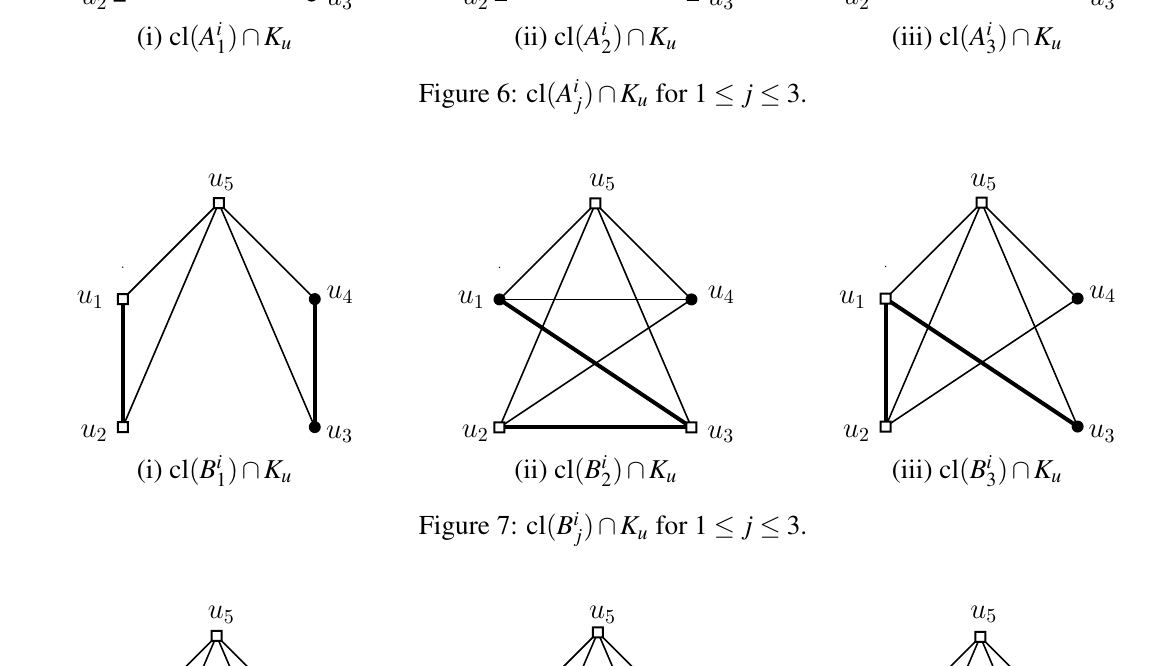
Figure 6: cl ( A i